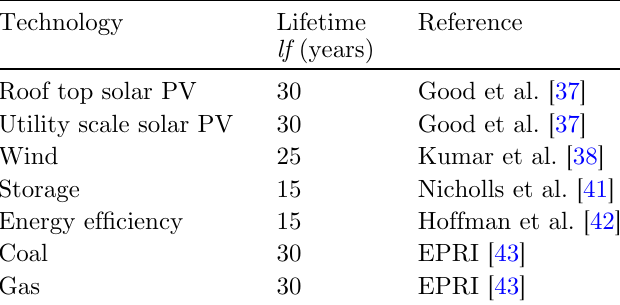
Table 3. Plant lifetimes for different energy generation and storage technologies.